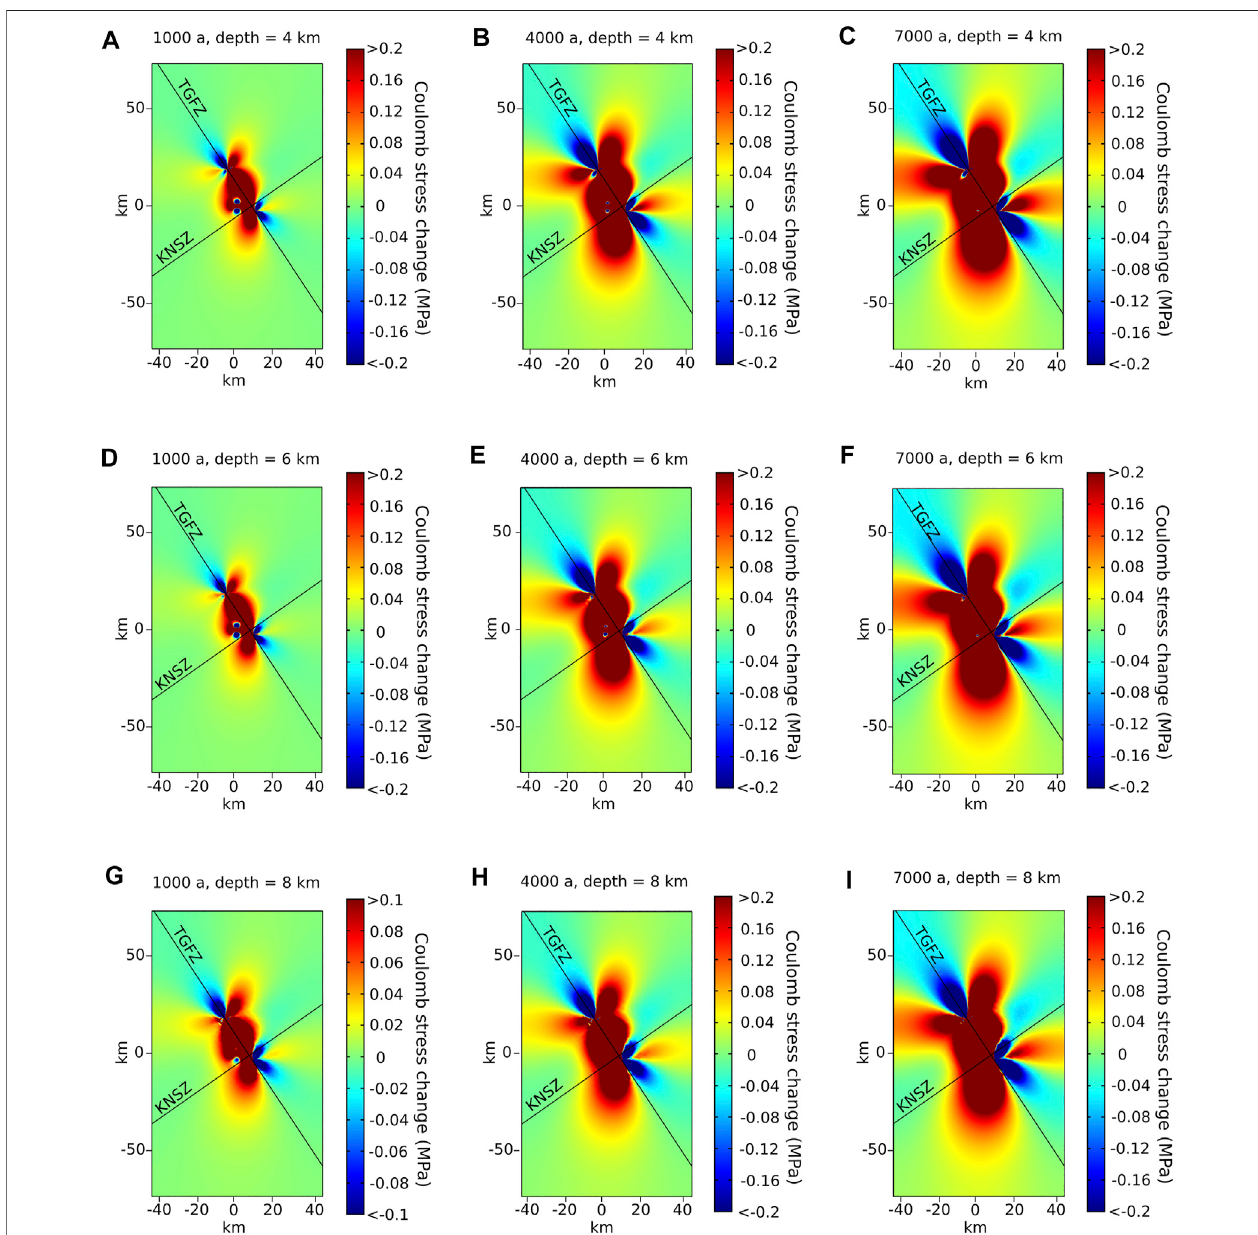
FIGURE 6 | Modeled gradual Coulomb failure stress changes at selected depths on vertical planes parallel to the Karaman-Ni ğ de shear zone (trending 55 ° NE) after 1000,4000and7000 yearssincethemostrecentearthquakeontheAKFS.Changesarecalculatedforthemoreplausibleslowgradualsliprateof0.58 mm yr − 1 right-lateral and 0.0536 mm yr − 1 normal slip. Coulomb failure stress changes at 4 km depth (A – C) , 6 km depth (D – F) and 8 km depth (G – I) . Note the reduction in scale in panel (G) .